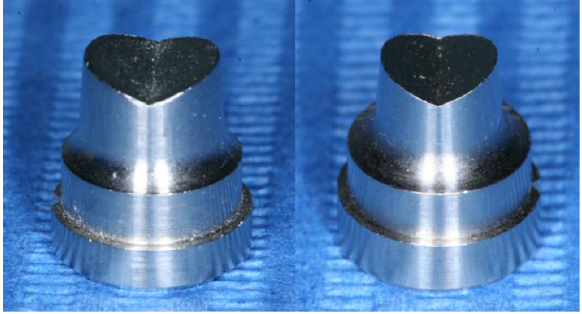
Figure 1. Dies with 6-degree preparation angle ( left ) and 12-degree preparation angle ( right ).